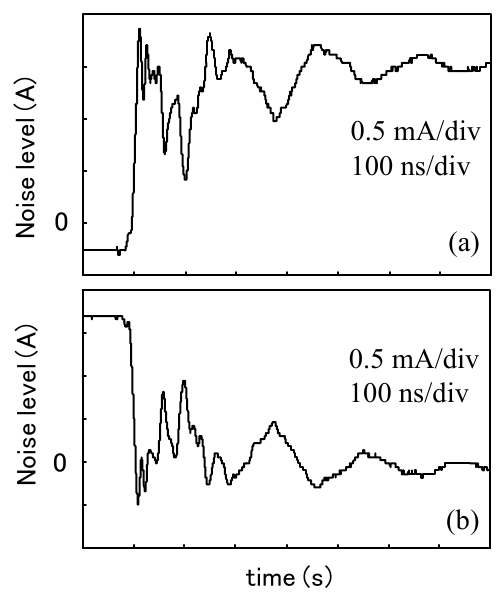
Figure 5. Step responses of the common-mode noise for: ( a ) up-step, ( b ) down-step.